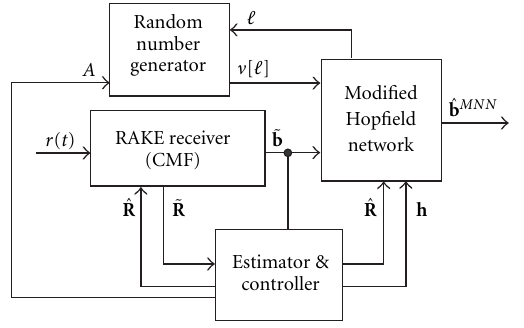
Figure 4: The structure of the proposed